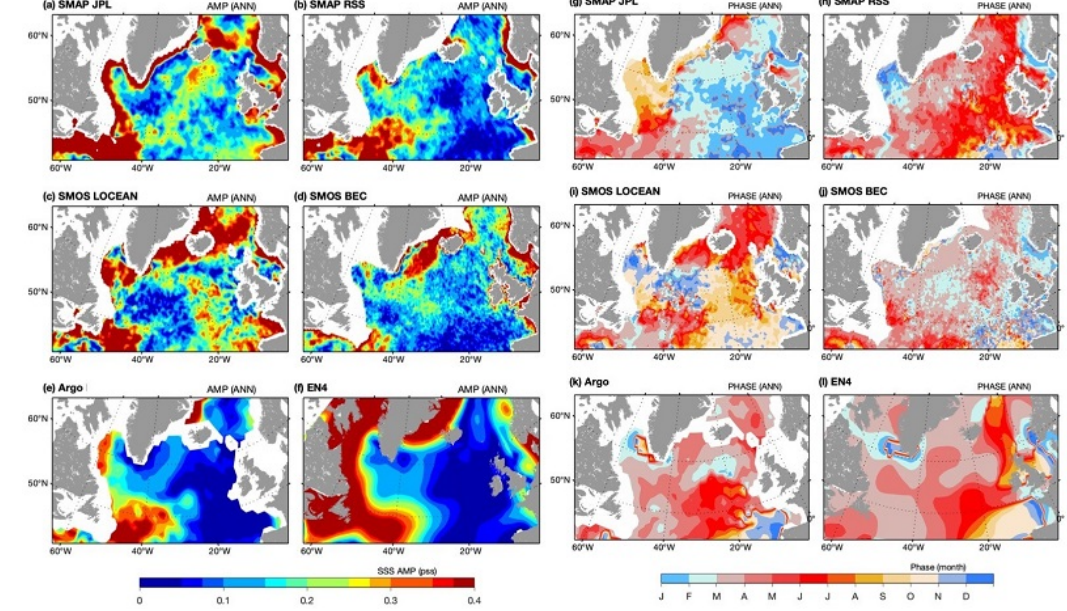
Figure 5. Amplitudes ( a )–( f ) and phases ( g )–( l ) of the annual SSS cycle for all six